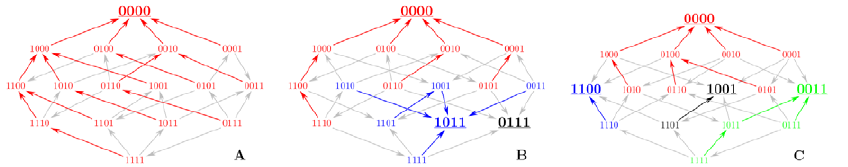
Figure 1. Graphical representation of three fitness landscapes of size m ~ 4 extracted from the empirical 8-locus fitness data set for A.niger . The presence/absence of a given mutation is indicated by 1/0. Arrows point towards higher fitness, local maxima are enlarged and underlined, and colors mark basins of attraction of maxima under a greedy (steepest ascent) adaptive walk. (A) All combinations of mutations argH12 , pyrA5 , leuA1 , oliC2 . This landscape has a single fitness maximum (the wildtype), but only 9 out of 4!=24 paths from {1111} to {0000} are accessible. (B) Mutations argH12 , pyrA5 , leuA1 , pheA1 . This landscape has three maxima and no accessible path. (C) Mutations fwnA1 , leuA1 , oliC2 , crnB12 . The landscape has four maxima and 2 accessible paths.